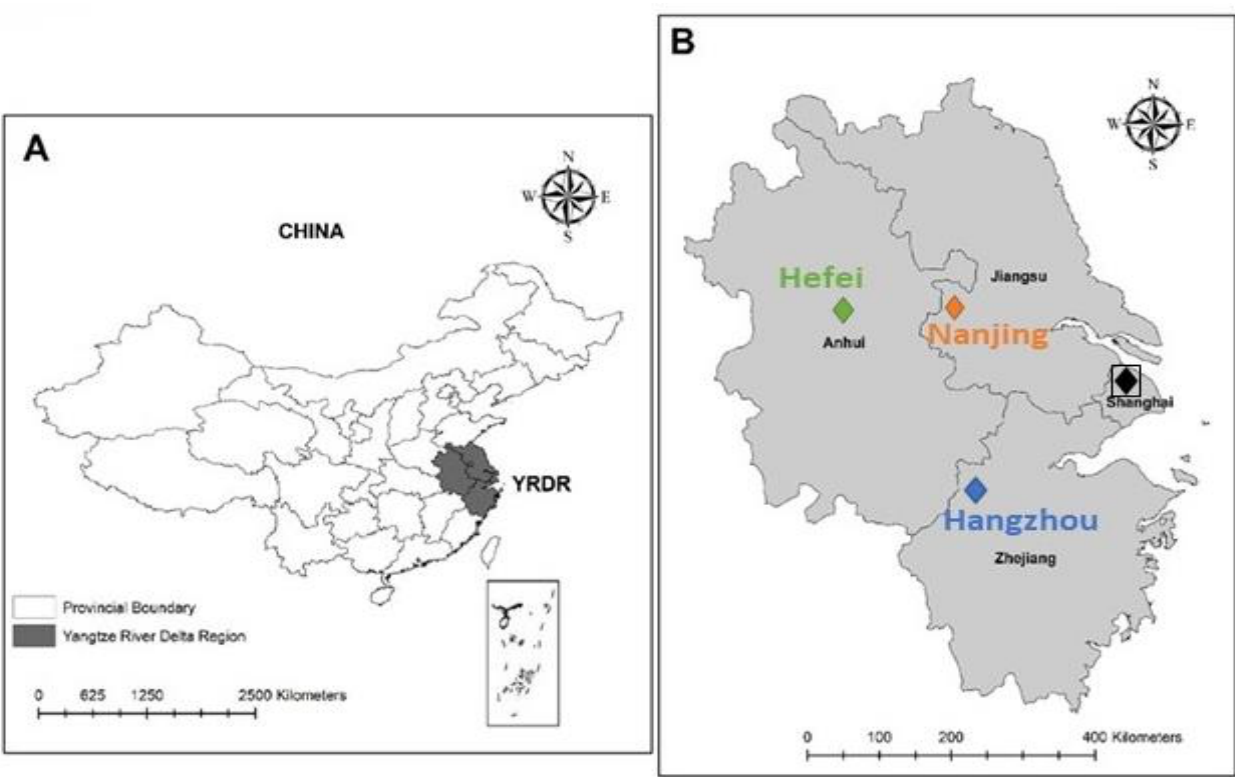
Figure 1. ( A ) The People’s Republic of China map showing the location of ( B ) the Yangtze River Delta